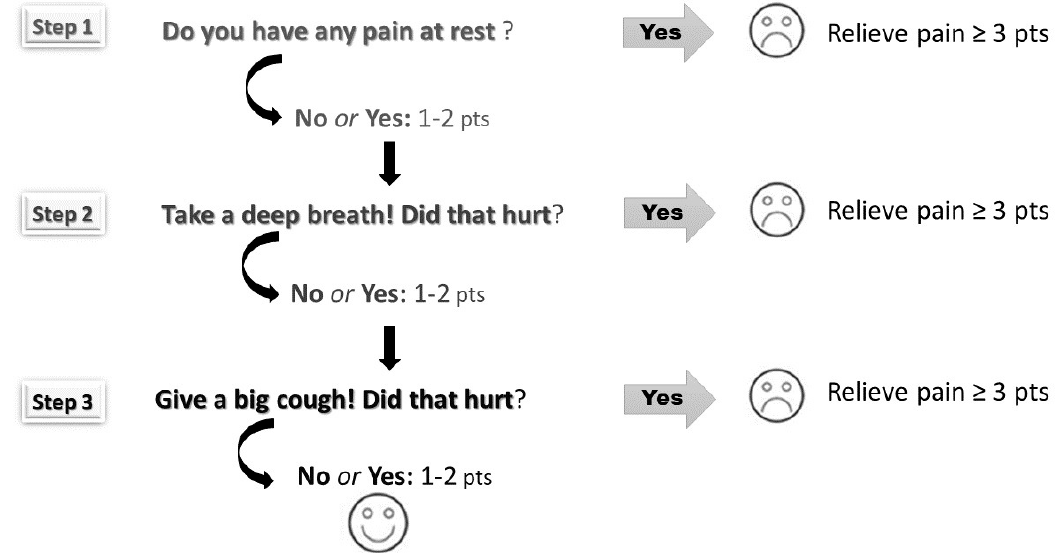
Figure 1. The three-step pain assessment method (the pain was assessed at rest, during deep breathing, and coughing according to the Numerical Rating Scale ranging from 0 points to 10